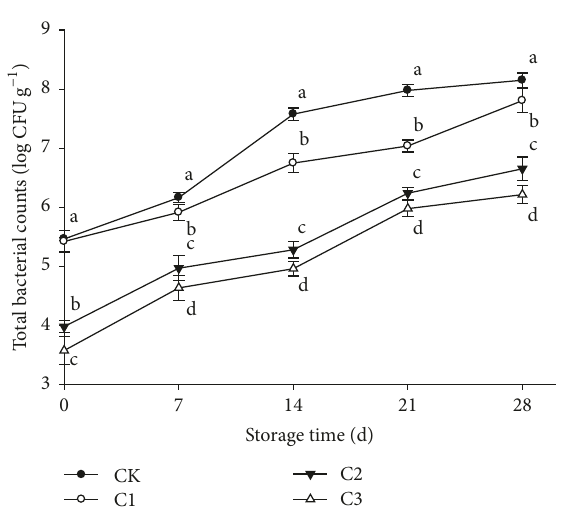
Figure 3: Changes in pH of beefsteaks with different treatments during storage. CK, the group of beefsteaks without pretreatments; C1, the group of beefsteaks pretreated with 100% CO for 1.5h; C2, group of beefsteaks pretreated with 100% CO for 1.5h and soaked in 50 mg/L ClO 2 ; C3, group of beefsteaks pretreated with 100% CO for 1.5 h and soaked in 50mg/L ClO 2 for 10min and sprayed with 30 g/L lactic acid. Data were represented with mean values ± Standard Error; sometimes the bars were too small to see. Different letters mean significant difference of samples with different treatments on the same storage days ( 𝑃 < 0.05 ). Three separate steaks of each treatment were measured; three repetitions were performed for each treatment. 𝑛 = 9